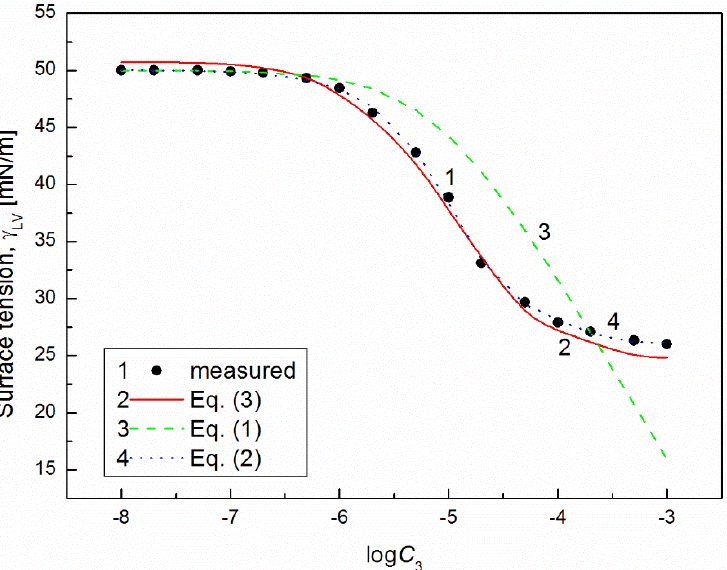
Figure 2. A plot of the surface tension ( γ LV ) of the aqueous solutions of CTAB + TX100 + FC1 mixture at the constant concentration of the binary mixture CTAB + TX100 ( C 12 ) and γ LV = 50 mN/m (m1 (50)) vs. the logarithm of FC1 concentration ( logC 3 ). Points 1 correspond to the measured values, curves 2, 3 and 4 correspond the values calculated from the Fainerman and Miller (Equation (3)), the Szyszkowski equation (Equation (1)) and the second order exponential function (Equation (2)), respectively.